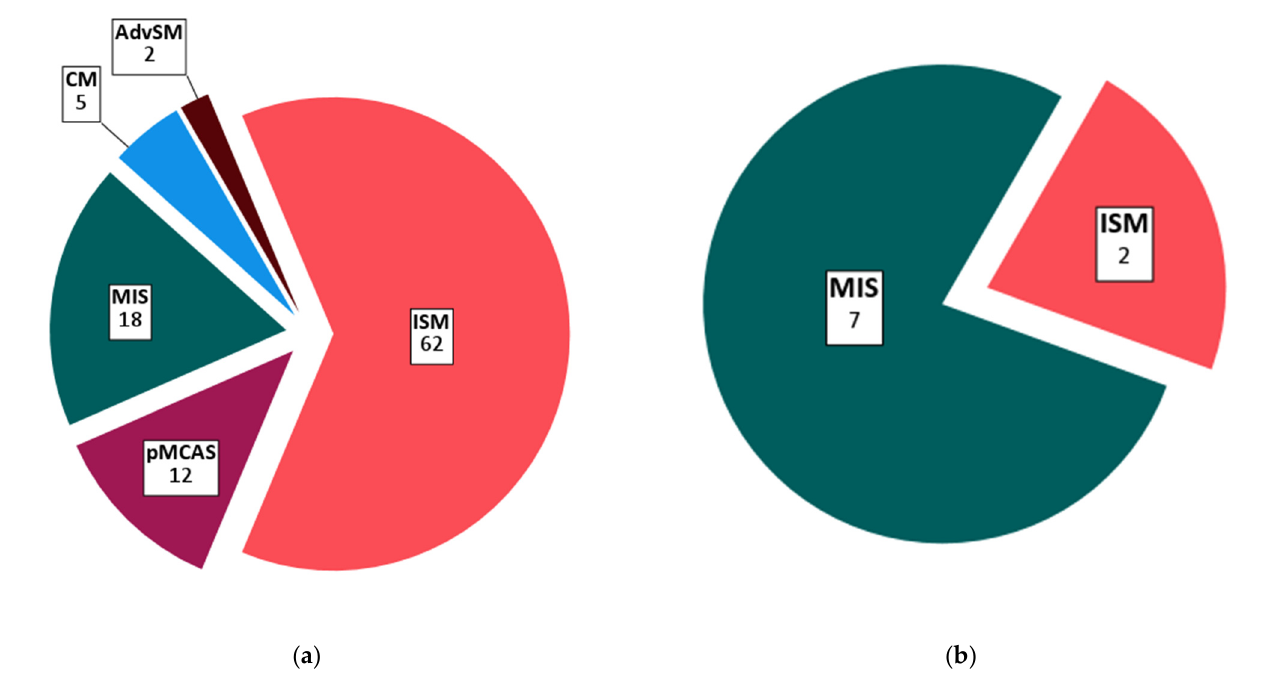
Figure 1. Distribution of primary mast cell disease subtypes: ( a ) Total population ( n = 99); ( b ) pediatric population ( n = 9, 12–18 years). Absolute patient counts for each subtype are indicated on the figure. Abbreviations: CM, cutaneous mastocytosis; MIS, mastocytosis in the skin; pMCAS, primary mast cell activation syndrome; ISM, indolent systemic mastocytosis; AdvSM, advanced systemic mastocytosis. Table 1. Baseline population characteristics.